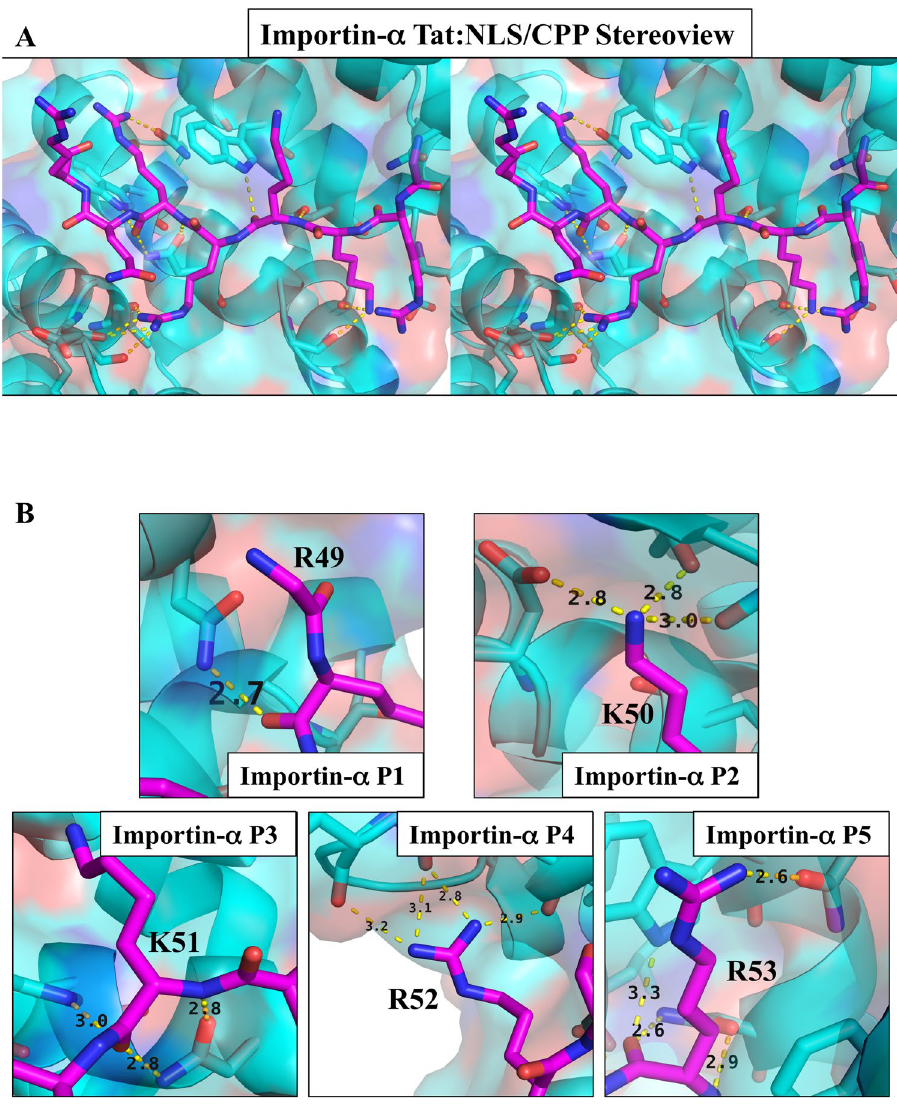
Figure 5. Importin- α interacting residues from Tat NLS/CPP region. ( A ) Importin- α shown in cyan (ribbons and surface view), Tat:NLS/CPP shown in magenta (sticks). NLS residues visible within crystal structure, and bound to the N-terminal concave ARM domains of importin- α , are shown in stereoview for 3D visualisation ( B ) Each P-site that interacts with importin- α is displayed with each interaction highlighted with dashed